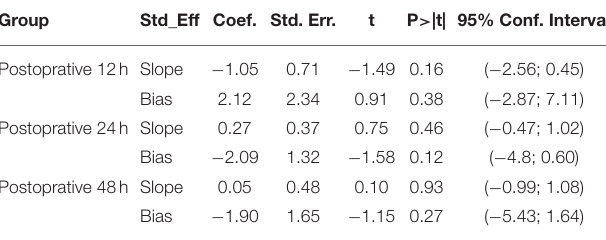
TABLE 10 | Egger’s test for publication bias of pairwise meta–analysis. Group Std_Eff Coef. Std.